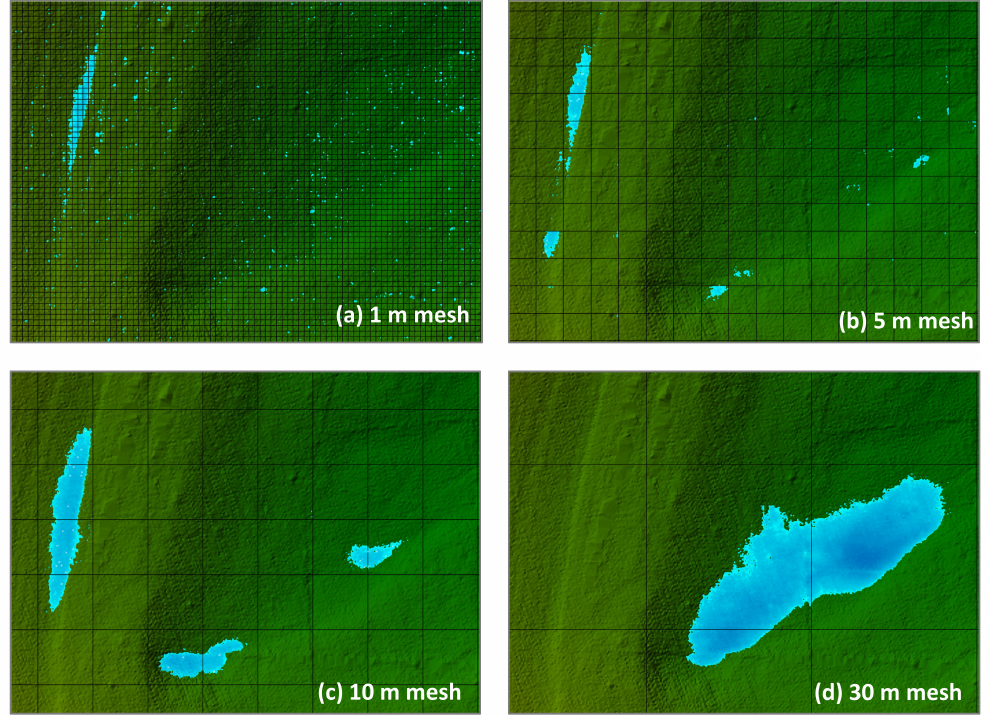
Figure 19. Remaining water in microrelief ( a ): 1 m, ( b ): 5 m mesh of the 0.25 m DEM and shallow artificial sinks ( c ): 10 m, ( d ): 30 m mesh at the end of the simulation